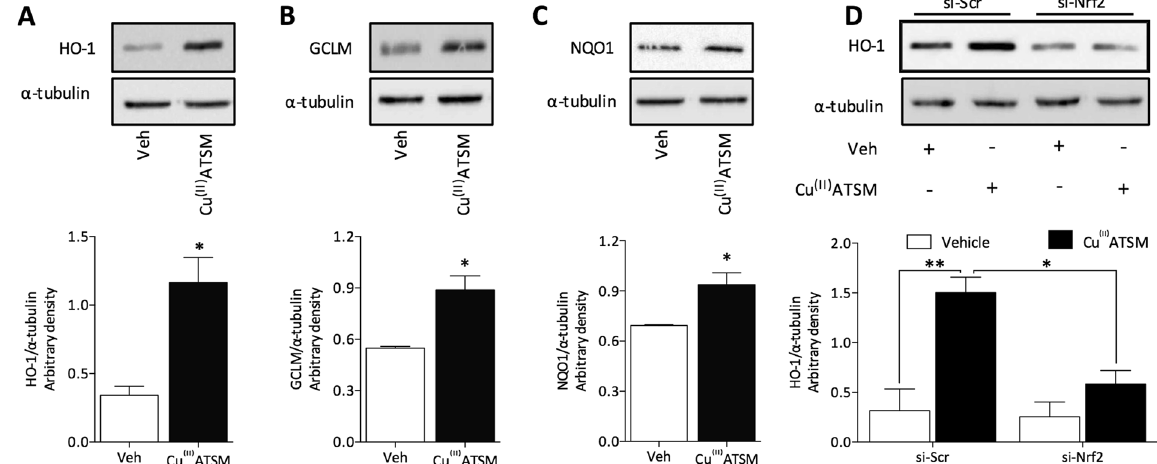
treated with Cu (II) ATSM (1 µ M, 12 h) and expression of ( A ) HO-1, ( B ) GCLM and ( C ) NQO1 assessed by immunoblotting with densitometric analysis relative to α -tubulin. Data denote mean ± S.E.M., n = 4, * P < 0.05 vs vehicle (Student’s t-test). (D) Induction of HO-1 in HCM in response to Cu (II) ATSM (1 µ M, 12 h) following transient transfection of cells with scramble (Scr) si-RNA or Nrf2 si-RNA. Data denote mean ± S.E.M., n =